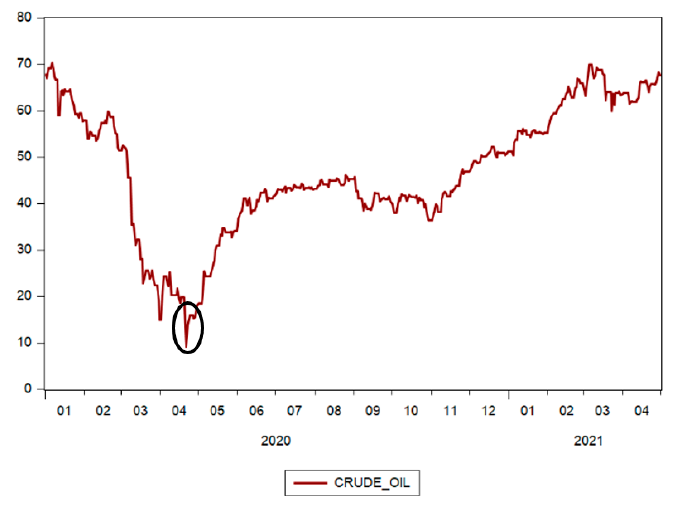
Figure 6. Brent Spot Price for crude oil. Source: authors’ contribution using EViews 10 software. At the beginning of 2020, the impact of COVID-19 on the manufacturing sector led to a record low on the Purchasing Managers’ Index (PMI) (Figure 7): in Europe, in April, when it reached the level of 33.4, although the previous months showed values also under 50; in the USA, the PMI reached a level similar to Europe, going under 50 in March, and the lowest level of 36.1 also in April; in China, the collapse of the manufacturing sector was not as strong as in Europe or the USA, and it reached its lowest level of 40.3 PMI in February, and then recovered quickly. The PMI grew over 50 in July of 2020 in Europe and the USA, while in China, it was over 50 during the entire period after the February decline, except for April, when there was a minor decline, without long-term consequences.